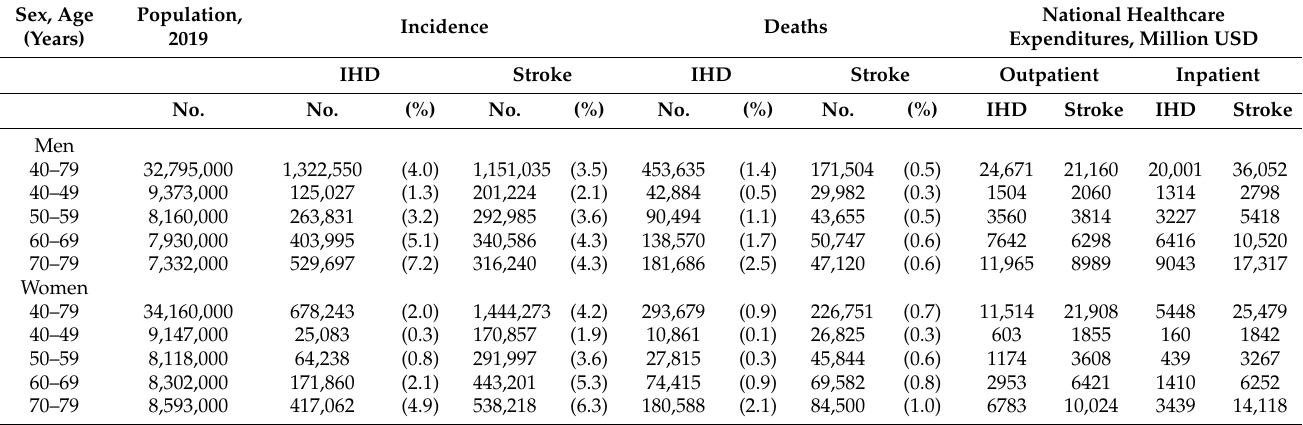
Table 2. Projected cumulative incidence, mortality, and national healthcare expenditures for ischemic heart disease (IHD) and stroke over 10 years from 2019 under the base-case scenario of mean dietary salt intake remaining at the levels of